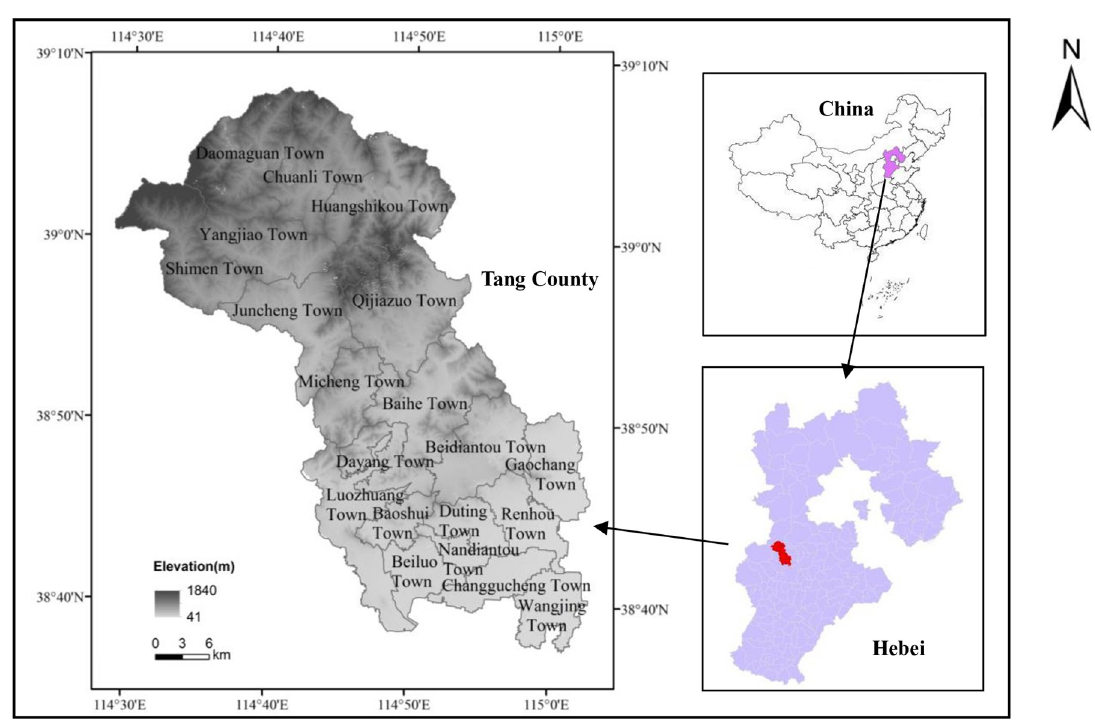
Fig 1. Location of the study area in Tang County district, Hebei Province,